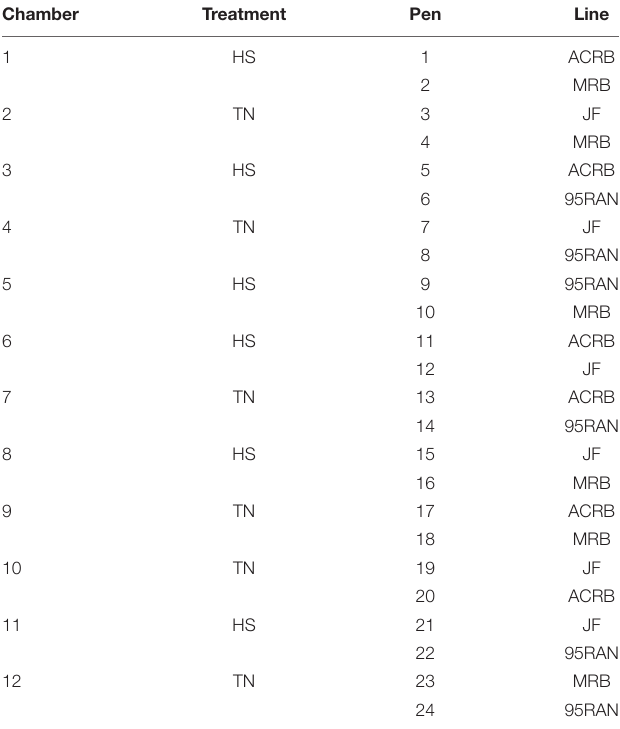
TABLE 1 | Experimental design and assignment of lines to chambers and pens. Chamber